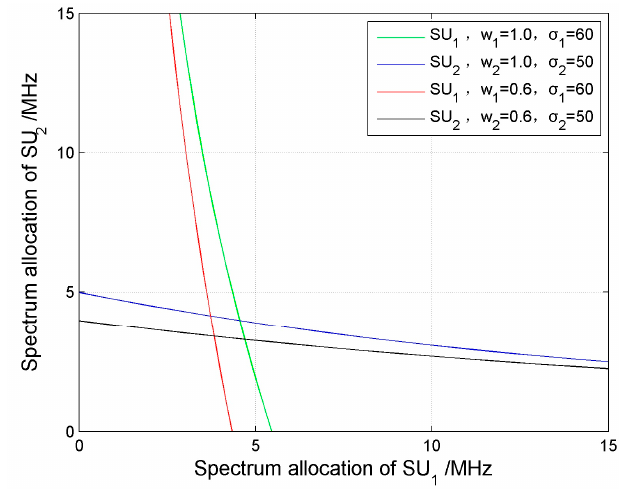
Figure 3. Best spectrum allocation curve and Nash equilibrium point under the static game.